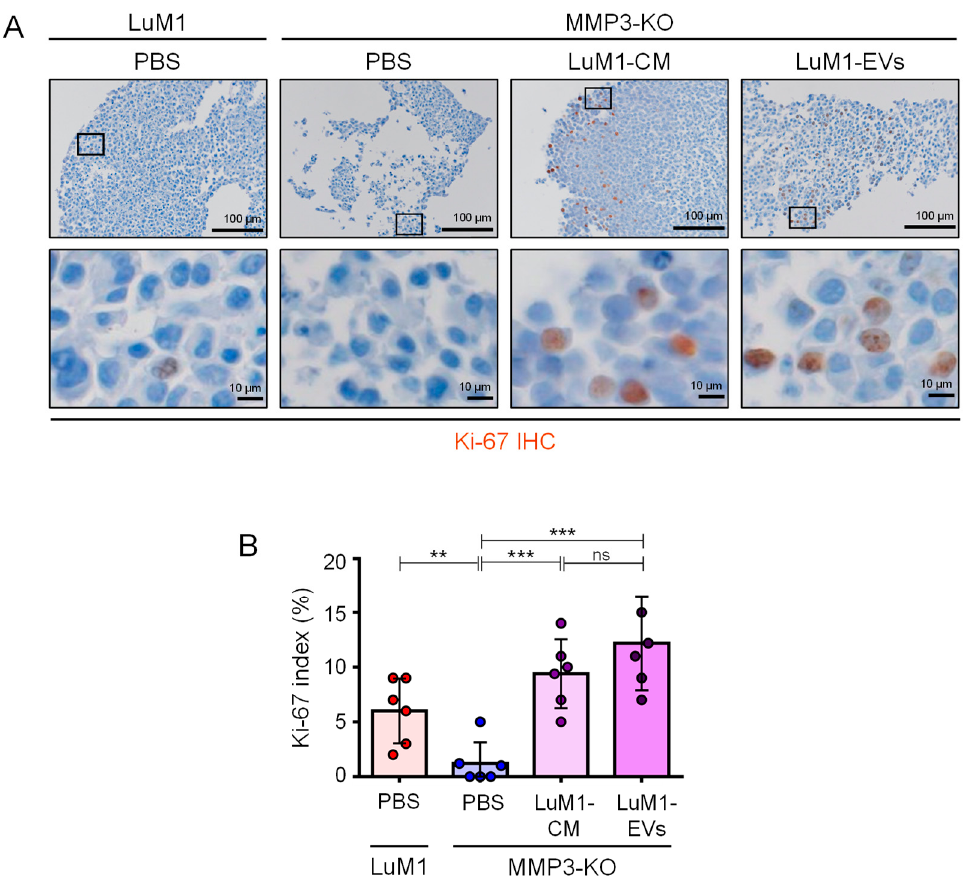
Figure 12. MMP3 enriched-EVs and CM rescue the proliferation of MMP3-KO tumoroids. LuM1-tumoroids or MMP3-KO tumoroids were treated with PBS, LuM1-CM, or LuM1-EVs for 24 h, and then Ki-67 was immunostained. ( A ) Ki-67 immunostaining (brown) in the LuM1 and MMP3-KO tumoroids. Scale bars; 100 µ m (in low magnification images) and 10 µ m (in high magnification images). ( B ) Ki-67 labeling index (%). n = 6, ** p < 0.01, *** p < 0.001; ns, not significant. Experiments were repeated twice.